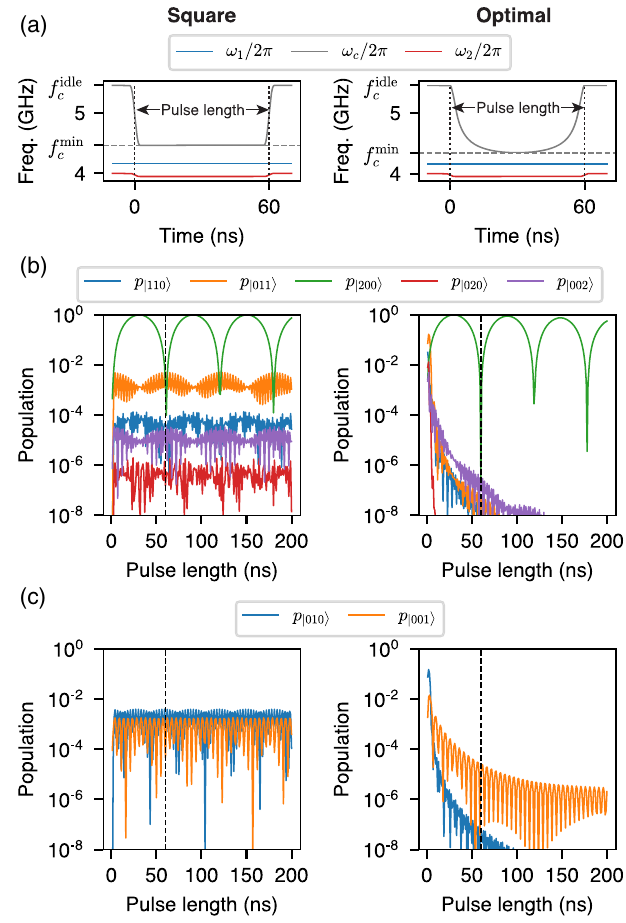
FIG. 18. Numerical simulation of coherent leakage of CZ gates. (a) Square-shaped and optimal control waveforms for 60-ns-long CZ gates, respectively. (b) Coherent leakage in the double- excitation manifold. We prepare j 101 i , apply a control pulse, and then measure the state populations. By using the optimal pulse shaping, we suppress population of the leakage state j 011 i (orange curve) below 10 − 7 for pulses longer than 60 ns. (c) Co- herent leakage in the single-excitation manifold. We prepare j 100 i , apply a control pulse, and then measure the state populations. By using optimal pulse shaping, we suppress population of the leakage state j 010 i (blue curve) below 10 − 7 for pulses longer than 60 ns. The leakage to j 001 i is not suppressed as much, since the optimal control relies on the effective Hamiltonian H CZ ð t Þ that addresses only leakage from eff j 100 i to j 010 i in the single-excitation manifold. The data points in (b),(c) are obtained every 1